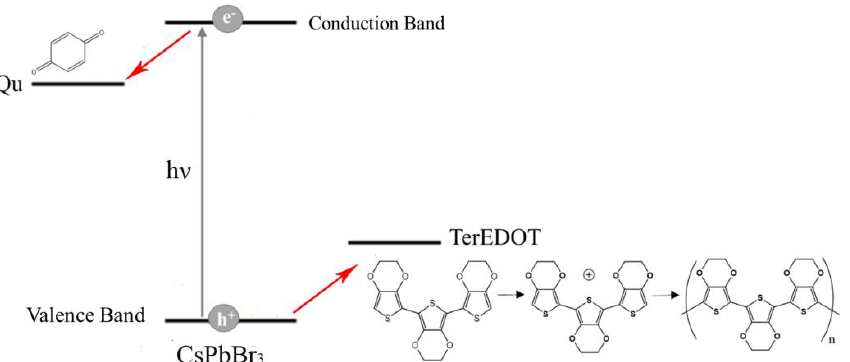
Figure 5. Normalized absorbance UV/Vis spectra ( A ) and Tauc plots ( B ) of 2/AS-IO-CsPbBr 3 and 2/RS-IO-CsPbBr 3 .